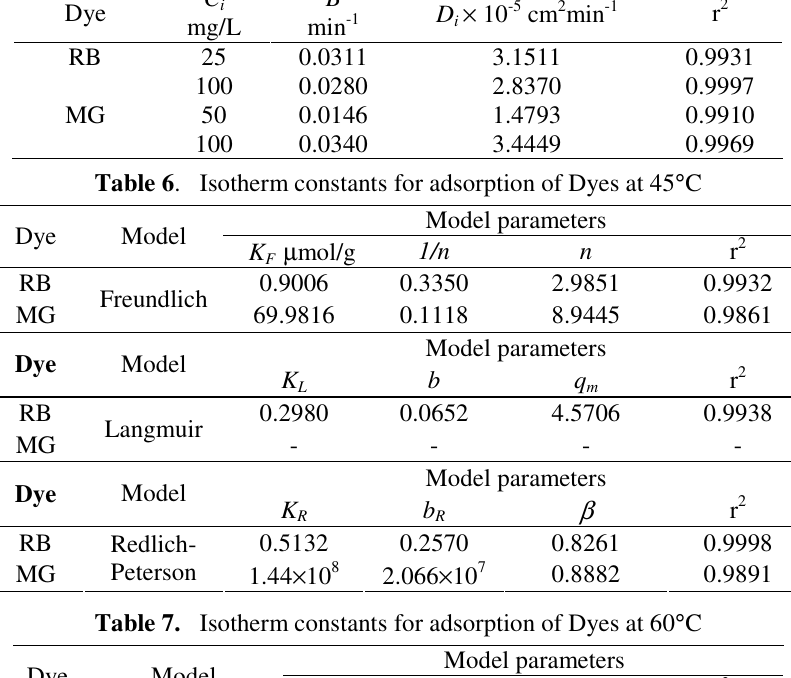
Table 5. Effective pore diffusion coefficients controlling the rate of adsorption at different initial concentrations of dyes on TFC